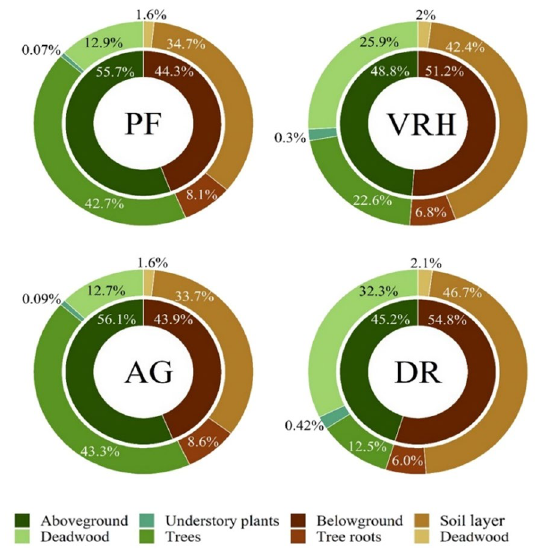
Fig. 2 Components of carbon content (%) classified according each category and biomass allocation (see Table 1) showing primary unmanaged forests (PF) and stands under variable retention harvesting (VRH) classified according the different retention types (AG: aggregated retention, DR: dispersed retention). The data are the mean of all the stands combining the years‑after‑harvesting samplings. Inner ring discriminates between biomass allocations (above‑ and below‑ground), while outer ring shows category x biomass allocation sub‑components